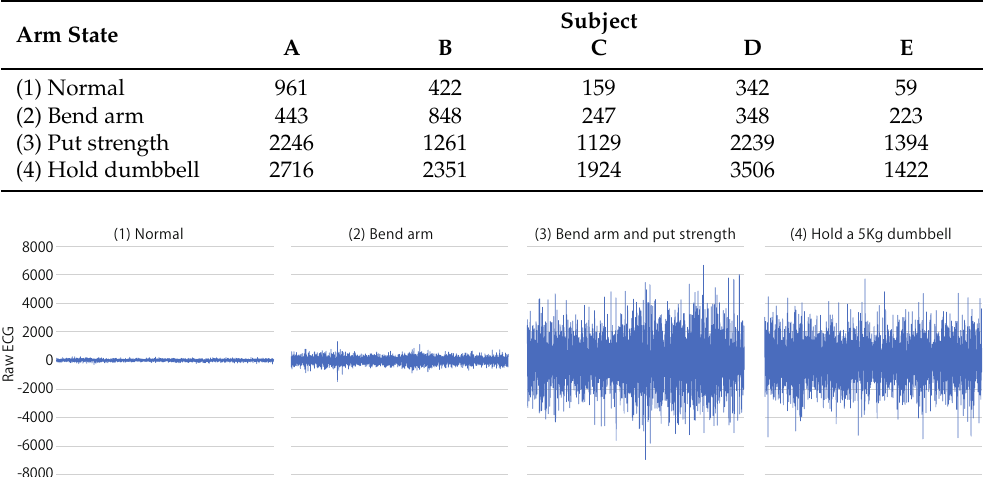
Figure 6. An example of raw ECG values in four states.